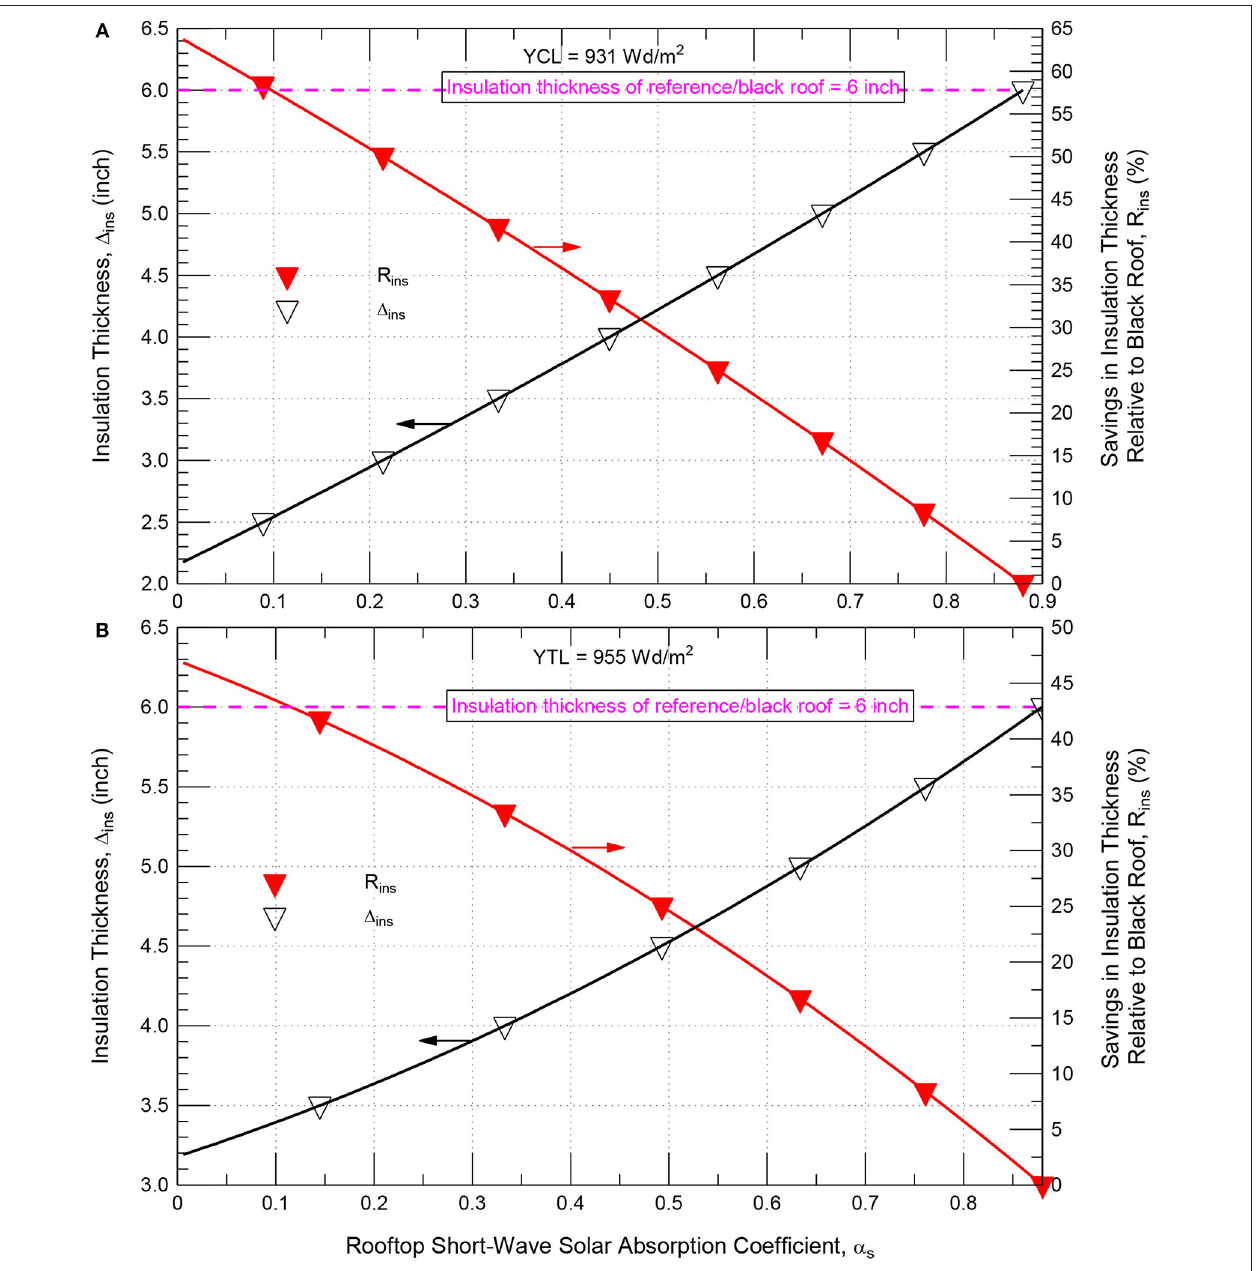
FIGURE 16 | Design chart for all pairs of 1 ins and α s and the corresponding reductions in insulation that provide the same contribution to (A) yearly cooling load (B) yearly total load as the reference/black roof of 1 ins = 152mm (6.0 inch).